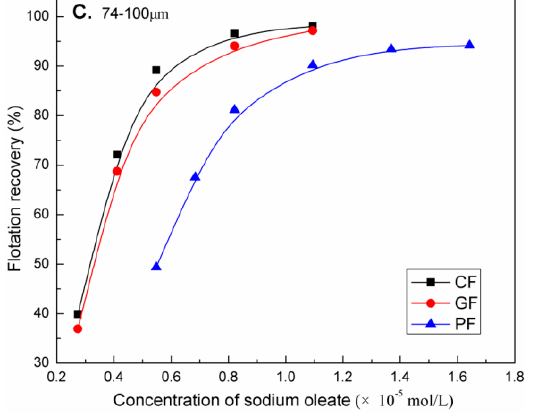
Figure 3. Flotation recovery of different colored fluorites as a function of NaOL dosage under neutral solutions: ( a ) 0–45 μ m, ( b ) 45–74 μ m, and ( c ) 74–100 μ m.